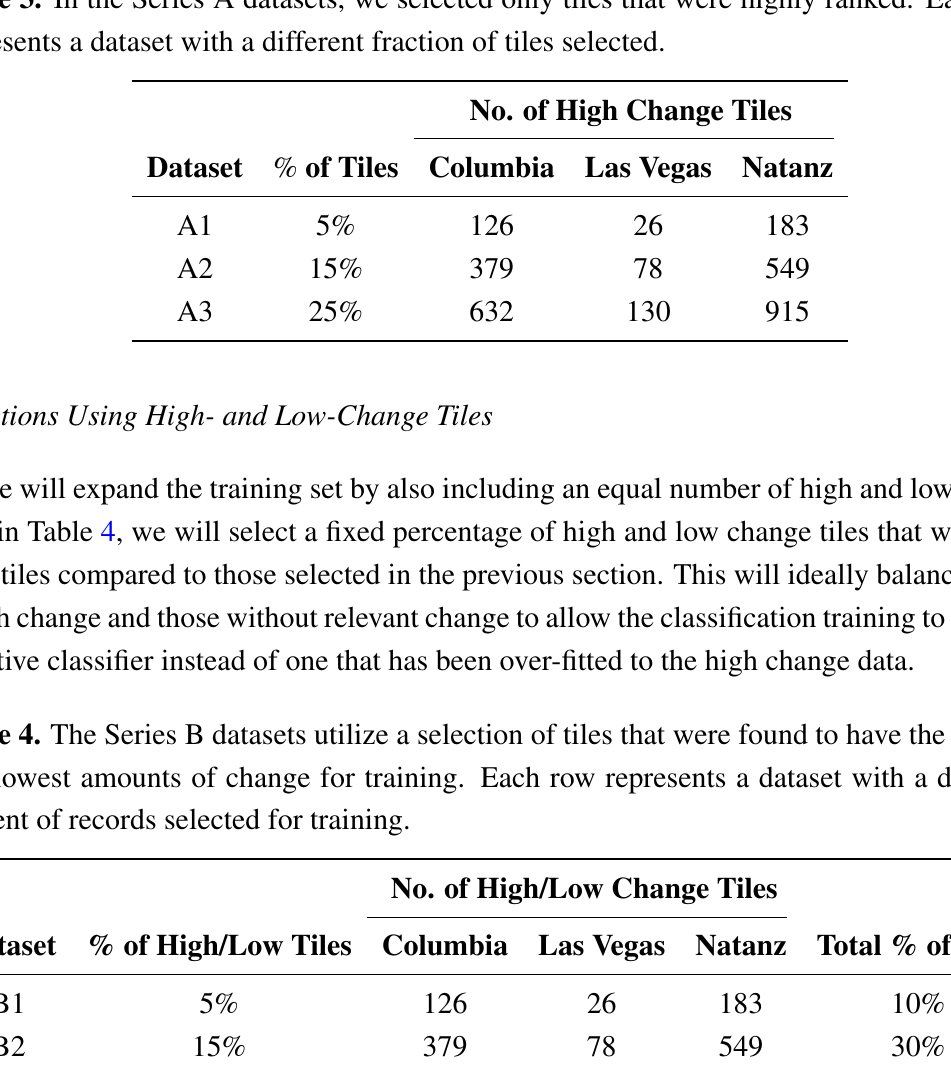
Table 3. In the Series A datasets, we selected only tiles that were highly ranked. Each row represents a dataset with a different fraction of tiles